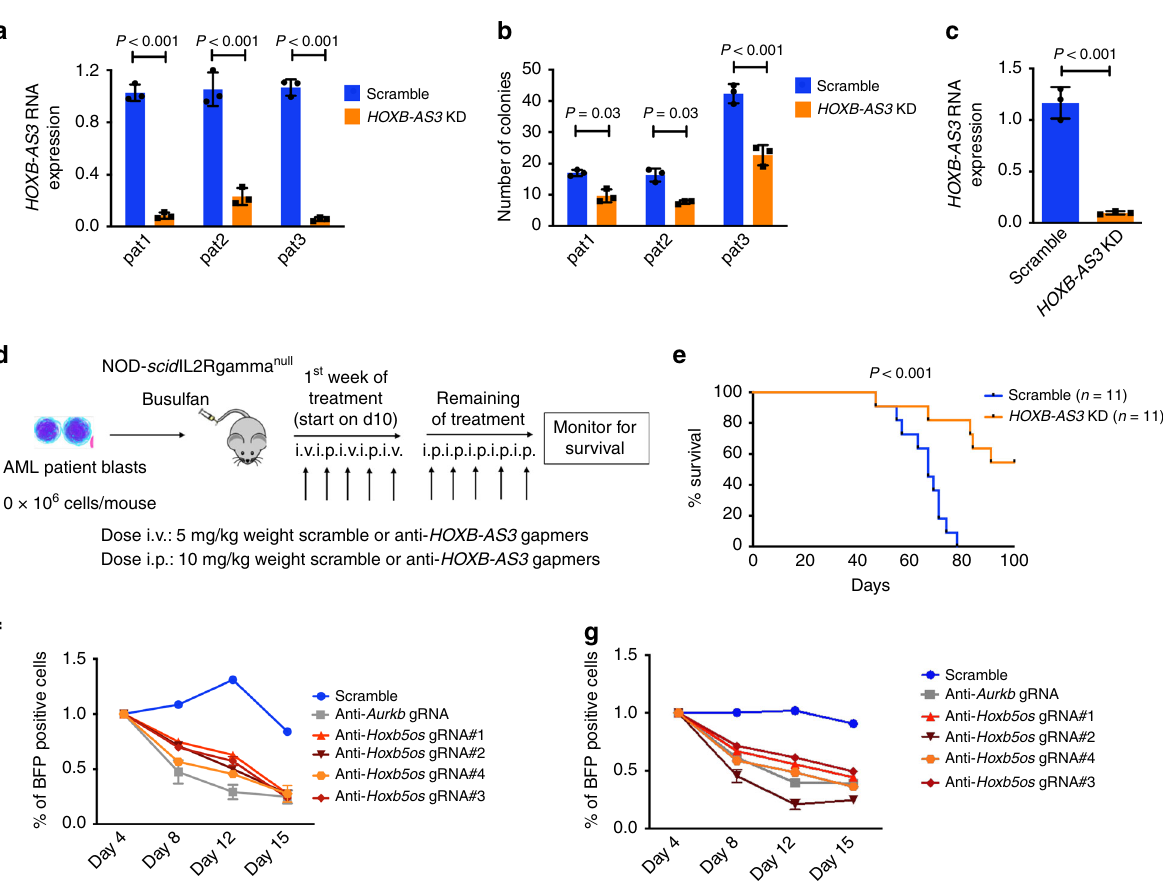
(Supplementary Fig. 6h – k). As HOXA9 overexpression has leu- kemogenic potential 35 , we further assessed HOXA9 protein levels by western blotting (WB). No difference in HOXA9 levels was